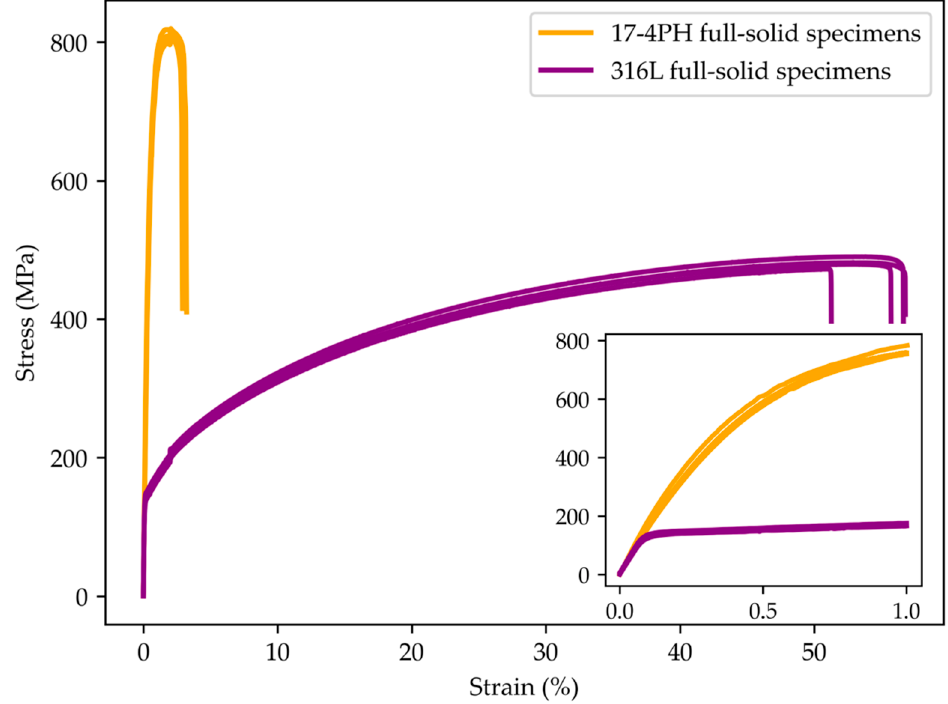
Figure 7. The stress–strain curves of 316L and 17-4PH stainless steel full-solid specimens. Table 3. The mechanical properties of 316L and 17-4PH stainless steel full-solid specimens.